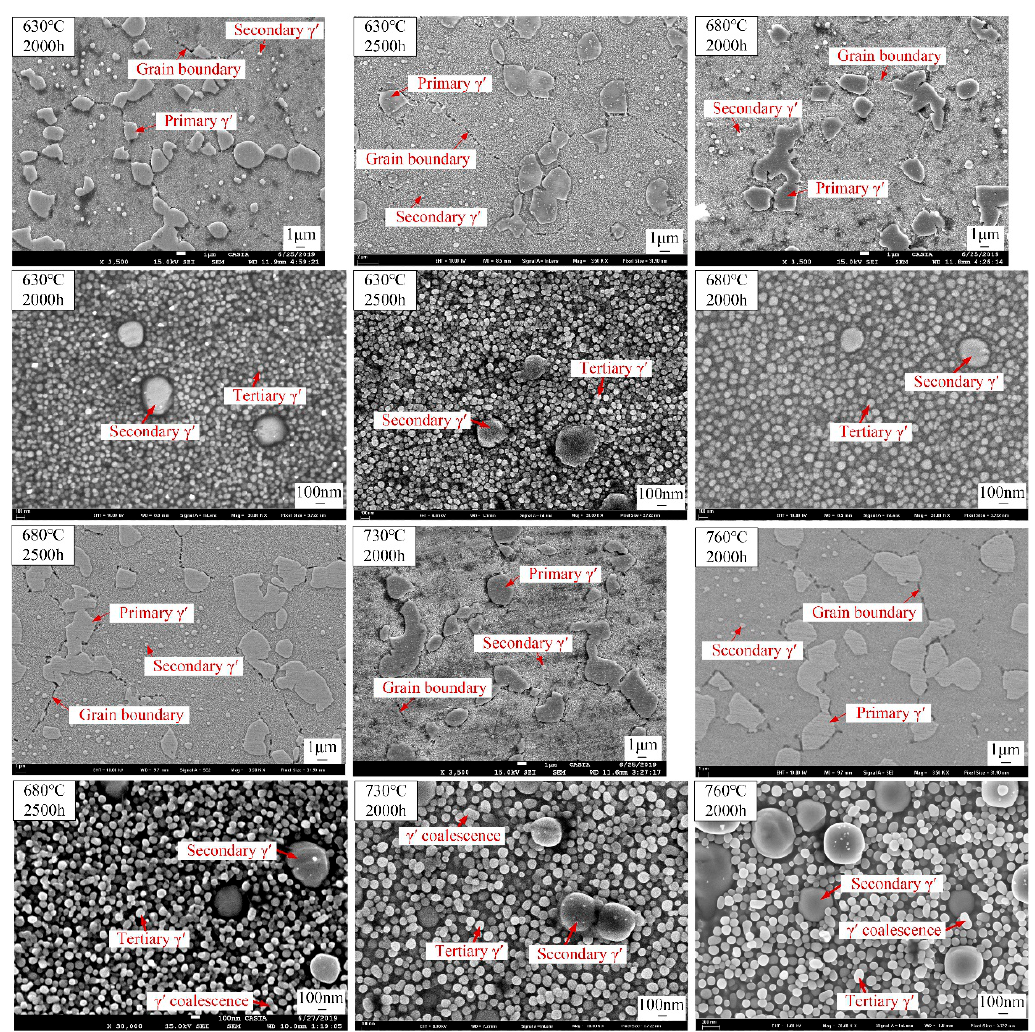
Figure 4. The γ’ morphology of the alloy under different thermal exposure conditions. Figure 4. The γ ’ morphology of the alloy under di ff erent thermal exposure